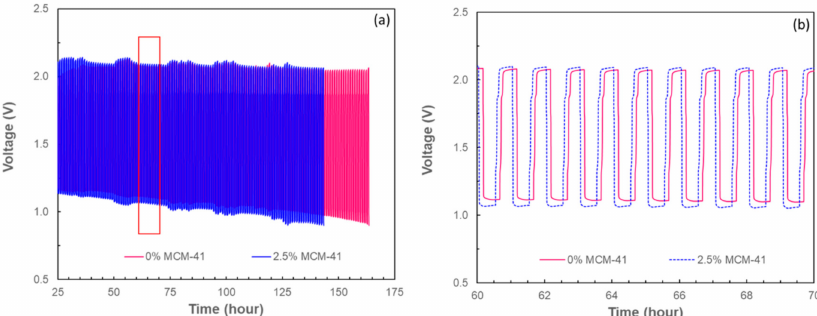
Figure 4. ( a ) The relation between charge–discharge voltage (V) and time (h) of rechargeable ZABs using PVA without MCM-41 and 0.25 wt.% MCM-41 / PVA composite membranes and ( b ) its expanded view at 60–70 cycle time (the region marked in red box in ( b